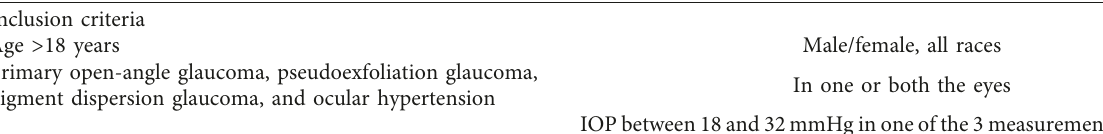
Table 1: Inclusion and exclusion criteria.